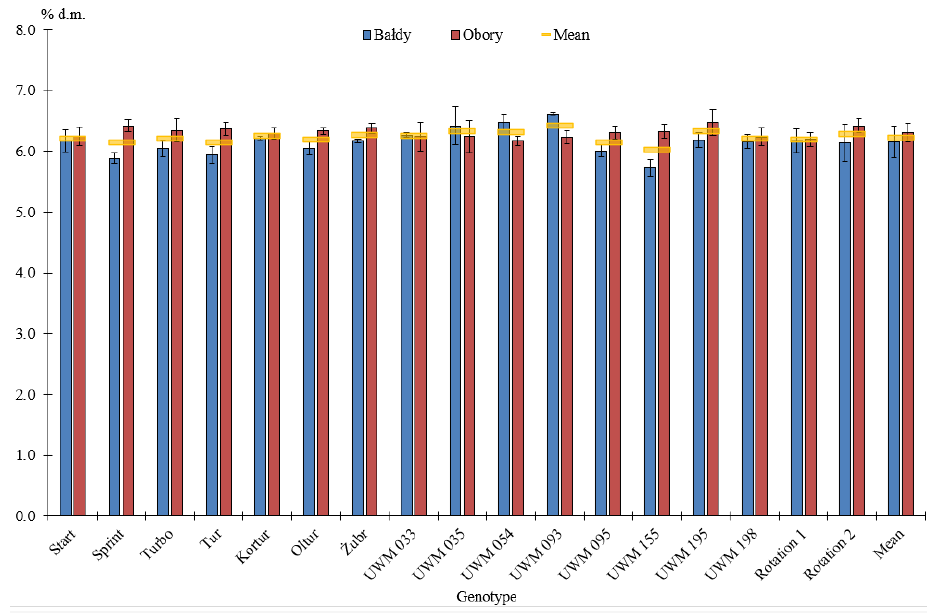
Figure 8. Hydrogen content in the biomass of 15 willow genotypes obtained at two locations in two consecutive three-year harvest rotations; (legend: see Figure 4